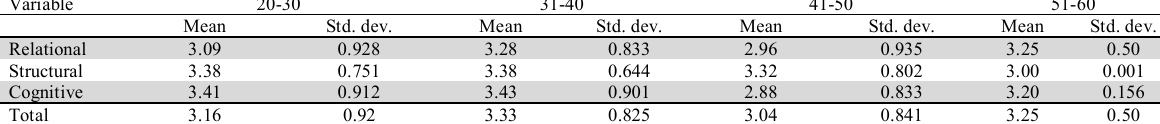
The summary of ANOVA for testing the effect of participants’ age Group Sum of Squares Degree of freedom Mean of Squares Between group 757.658 4 189.414 Inside group 24428.709 115 212.424 25186.367 119 F-value = 0.892 Sig. =